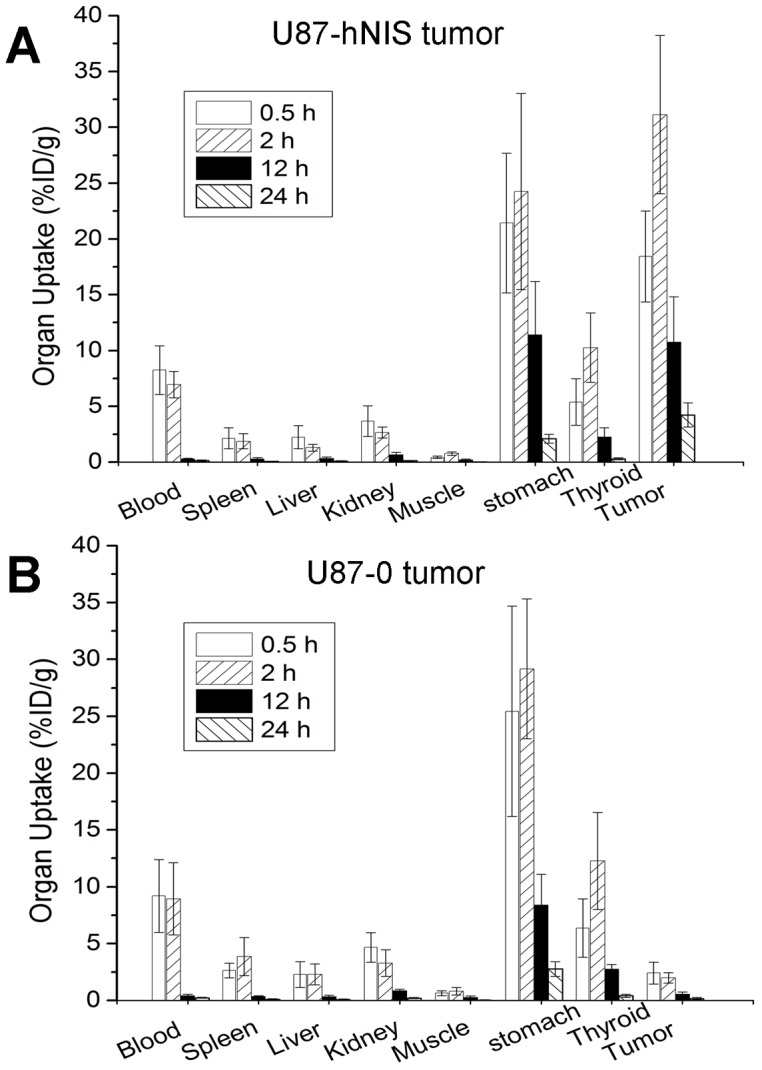
Biodistribution of 188Re in nude mice bearing subcutaneously xenografted U87-hNIS glioma tumors (A) and U87-0 glioma tumors (B).Data are expressed as the % ID/g of tissue. Bars are the mean ± standard deviation (n = 6).